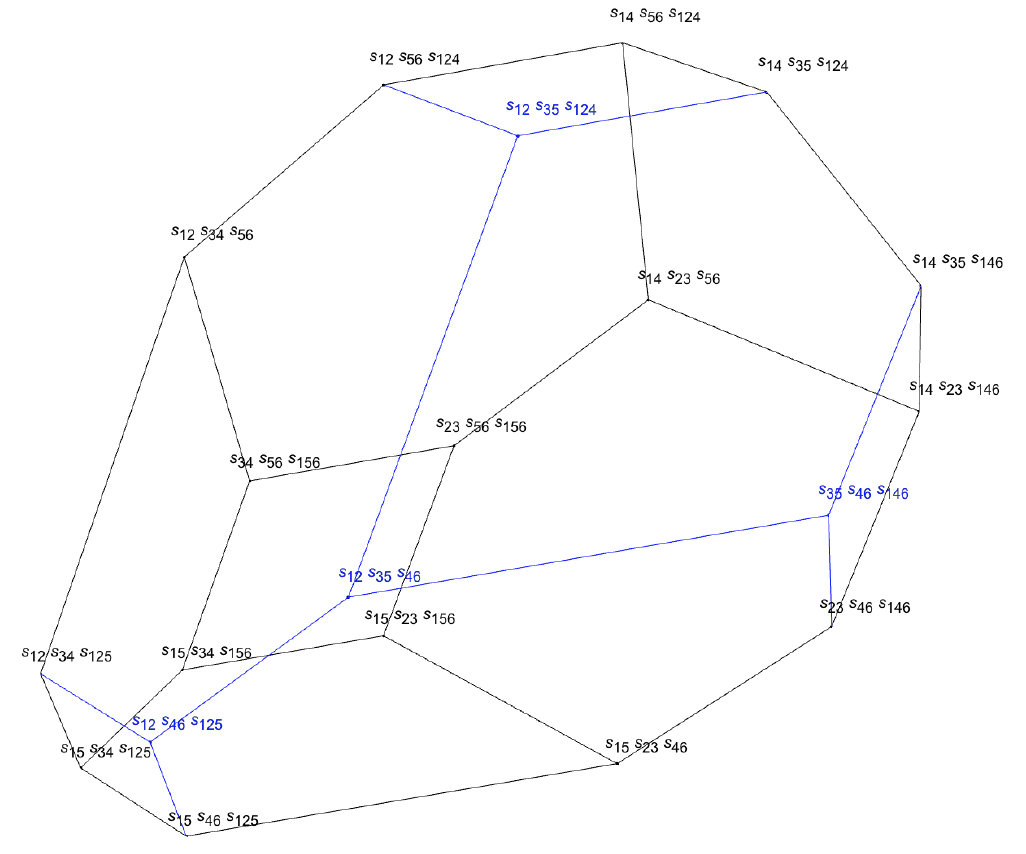
Figure 7. Combinatoric polytope from LS ( f (1 ; 2 ; 3) ; (1 ; 3 ; 4) ; (1 ; 3 ; 5) ; (4 ; 5 ; 6) g ). Here each vertex corresponds to a trivalent graph charactered by three